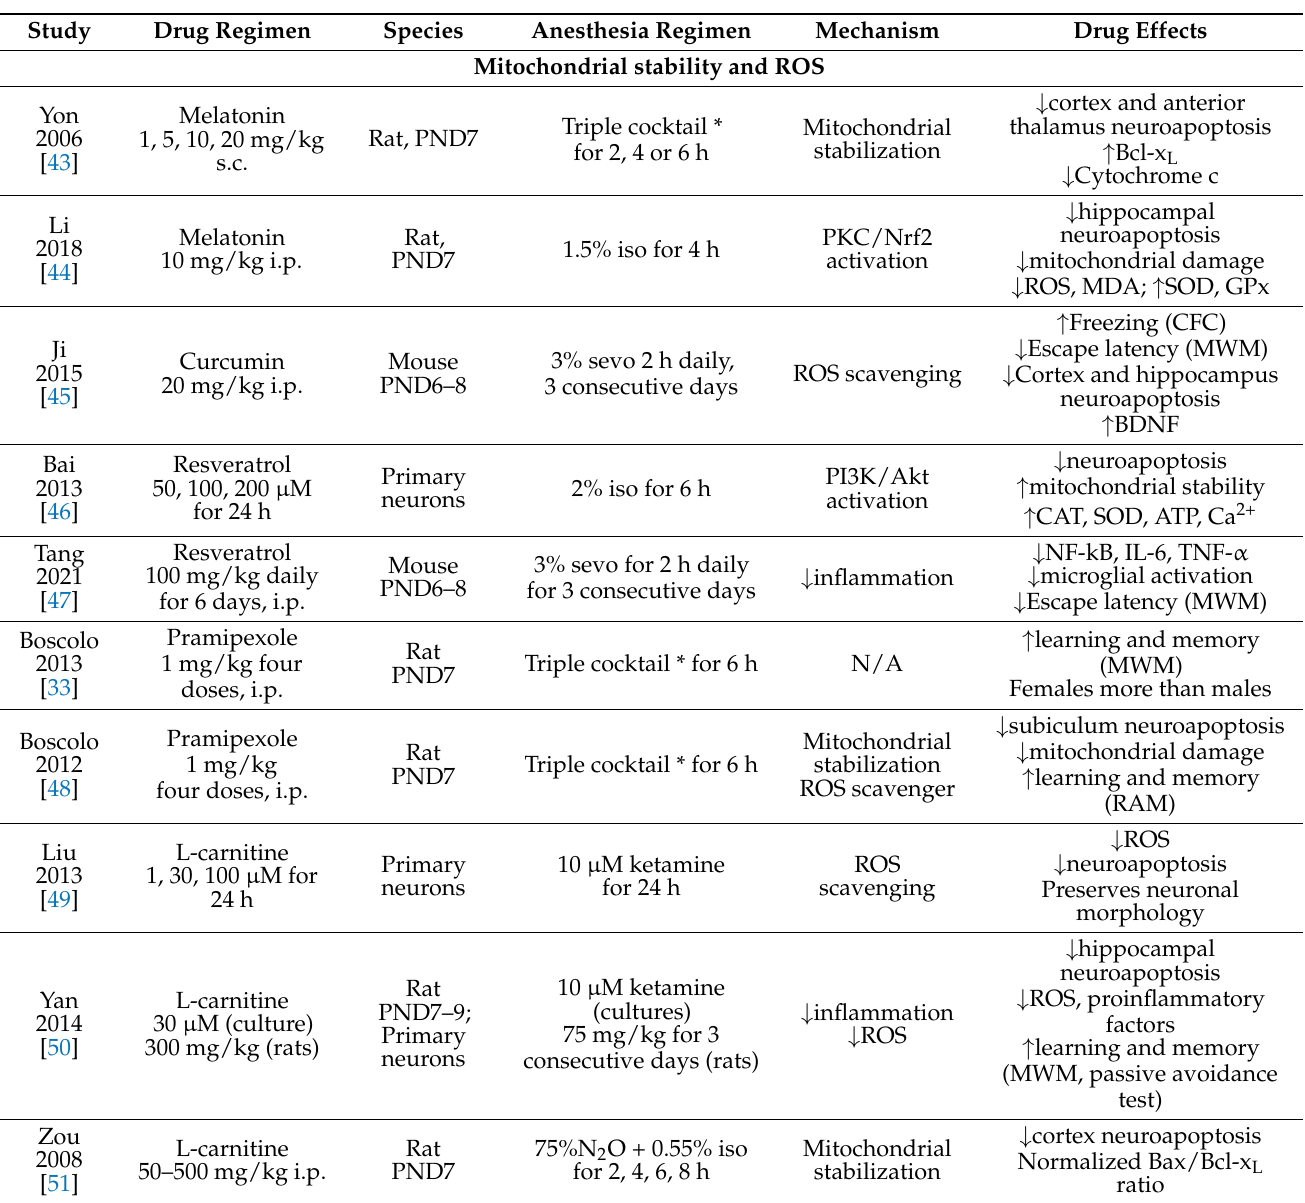
Table 1. Preclinical studies examining neuroprotective effects of various drugs in response to gen- eral anesthetics. s.c., subcutaneously; PND, postnatal day; i.p., intraperitoneally; iso, isoflurane; PKC, protein kinase C; Nrf2, nuclear factor E2-related factor 2; ROS, reactive oxygen species; MDA, malondialdehyde; SOD, superoxide dismutase; GPx, glutathione peroxidase; sevo, sevoflurane; ROS, reactive oxygen species; CFC, contextual fear conditioning; MWM, Morris water maze; BDNF, brain-derived neurotrophic factor; PI3K, phosphatydilinositol 3 kinase; CAT, catalase; ATP, adeno- sine triphosphate; NF-kB, nuclear factor kappa B; IL-6, interleukin 6; TNF- α , tumor necrosis factor alpha; RAM, radial arm maze; N 2 O, nitrous oxide; pAkt, phosphorylated Akt; GSK-3 β , glyco- gen synthase kinase 3 beta; EPO, erythropoietin; NGF, neural growth factor; NOR, novel object recognition; DEX, dexmedetomidine; MAPK, mitogen-activated protein kinase; ERK, extracellular signal-regulated kinase; pERK1/2, phosphorylated extracellular signal-regulated kinase 1/2; i.v., in- travenously; MCP-1, monocyte chemoattractant protein-1; CCR2, chemokine receptor type 2; SGZ, subgranular zone; SVZ, subventricular zone; NsTyr, N-stearoyl-L-tyrosine; HDAC, histone deacety- lase; HAT, histone acetyltransferase; CBP, CREB-binding protein; NMDA. N-methyl-D-aspartate; ↑ , increased/upregulated/improved; ↓ ,